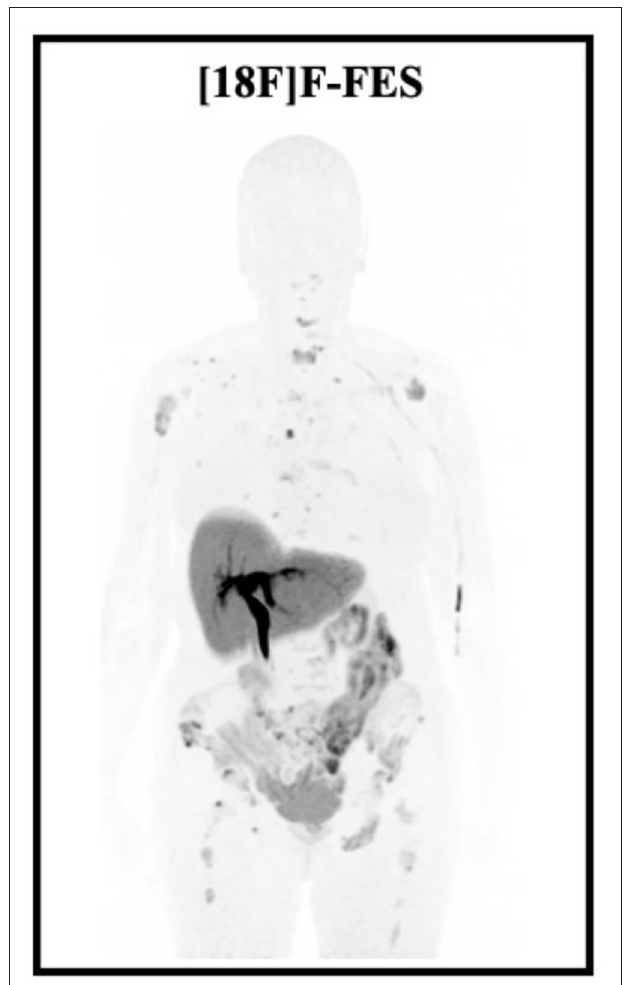
FIGURE 5 | Low intensity MIP images showing the normal biodistribution of [ 18 F]F-FES and multiple bone recurrence metastases of an ILBC, occured 5 years after surgery (SBRII, 15 mm, ER 80%, PR 80%, Ki67 40%, HER2 negative), radiotherapy and hormonotherapy with